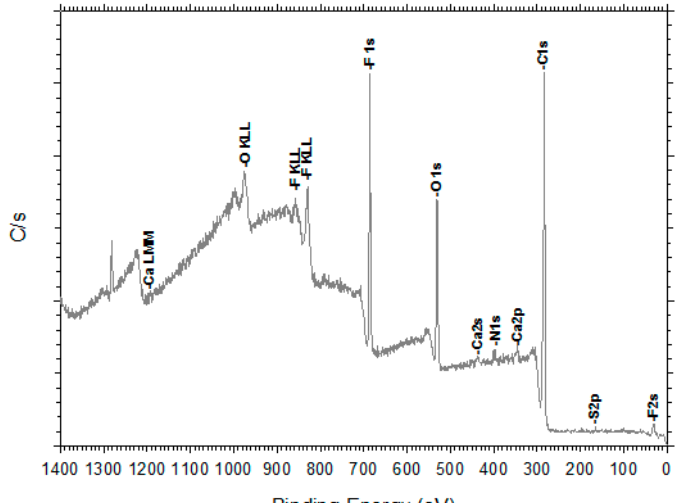
Figure 11. XPS spectrum for the HFM-183 membrane.